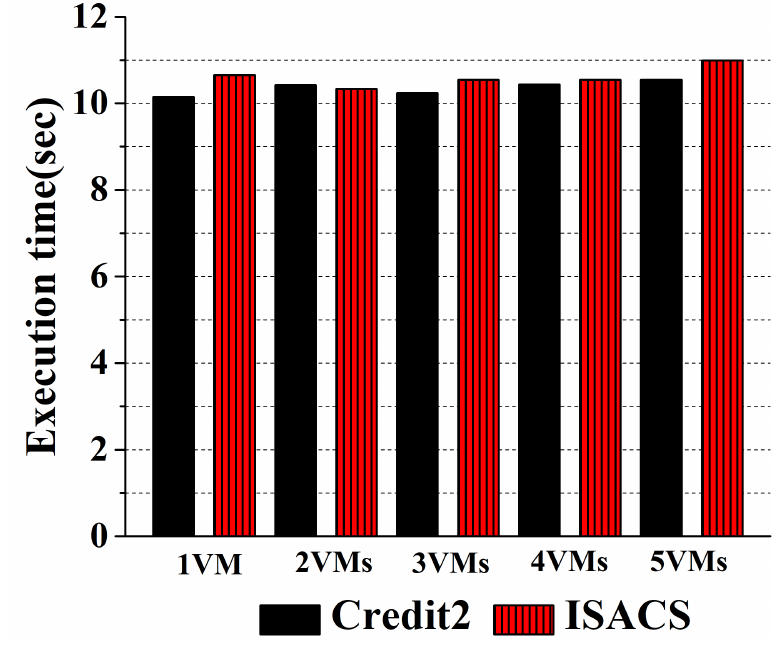
Figure 14. Average execution time of target-VM for 15 experiments according to the VM configuration in the hybrid environment.